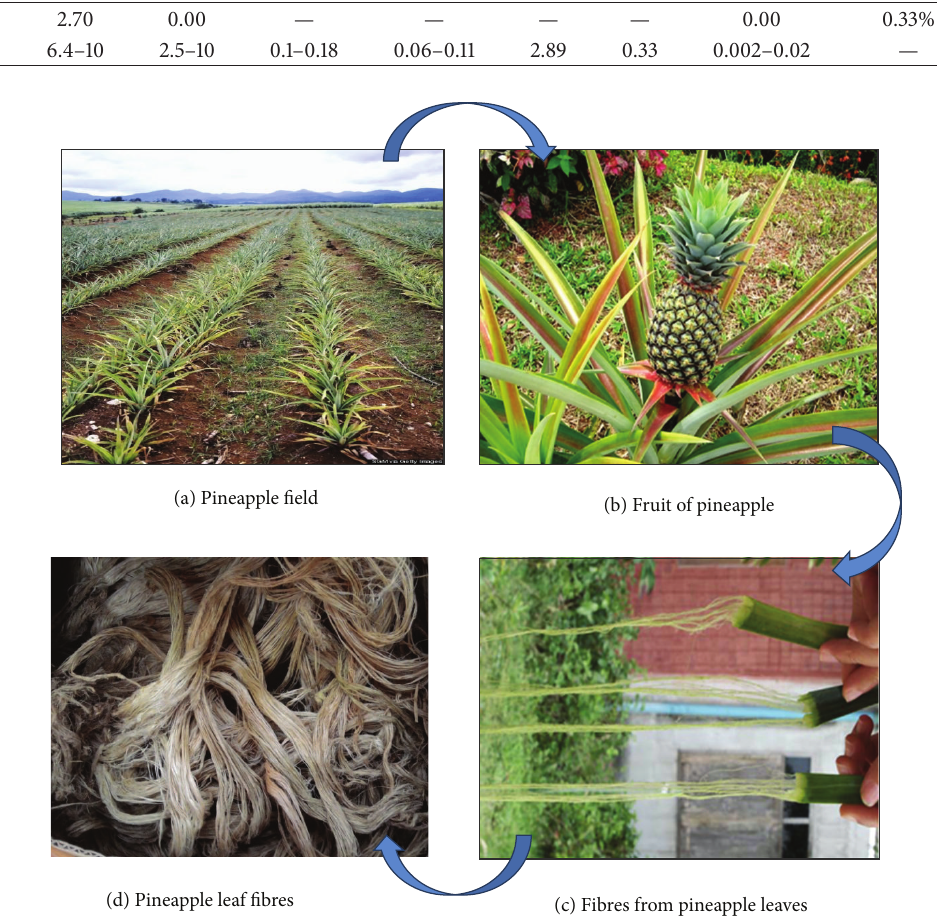
Figure1:Productionofpineappleleaffibre,sequential(a)plantationofpineapple,(b)fruitofpineapple,(c)extractionoffibresfrompineapple leaves, and (d) Indonesian